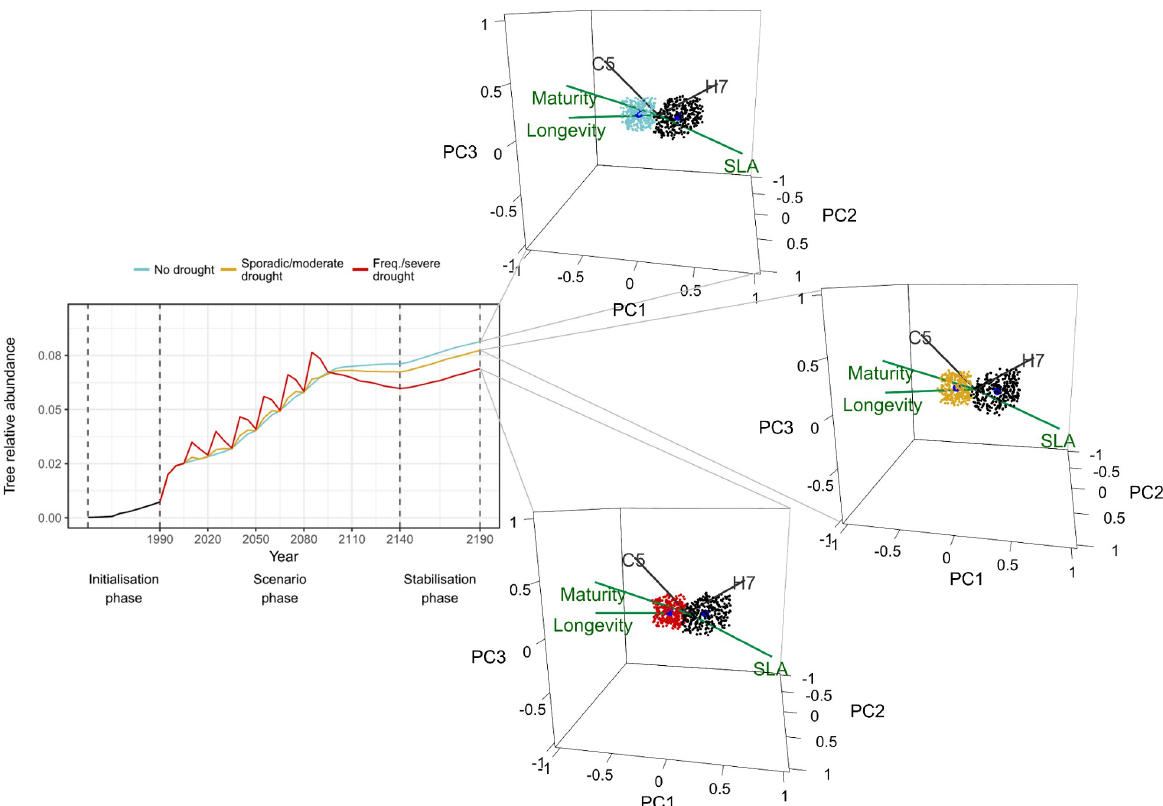
Fig 4. Managed grasslands. Effects of different drought scenarios on tree transient dynamics and on community states represented by hypervolumes. Current (in black) and future (blue, yellow and red) state hypervolumes are shown with their centroids (in dark blue). Five PFGs with the largest absolute factor loadings on the first three principal components are shown in grey. Functional traits with highest correlations with PC1 (traits with absolute coordinate values � 0.8) are shown in green. Trait vector coordinates were scaled by the corresponding trait vectors’ correlations with ordination axes (only traits with absolute coordinate values � 0.8 on PC1 are shown). For visual clarity, only 300 random sampled points are shown per